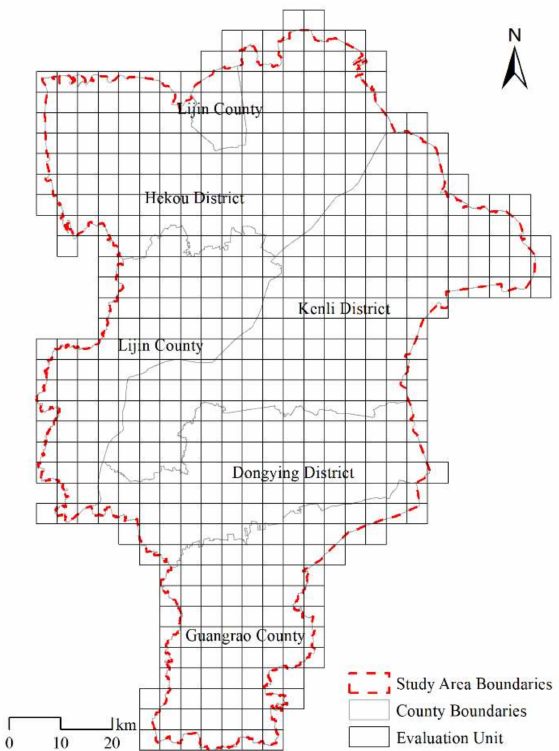
Figure 3. Spatial distribution of landscape ecological risk assessment